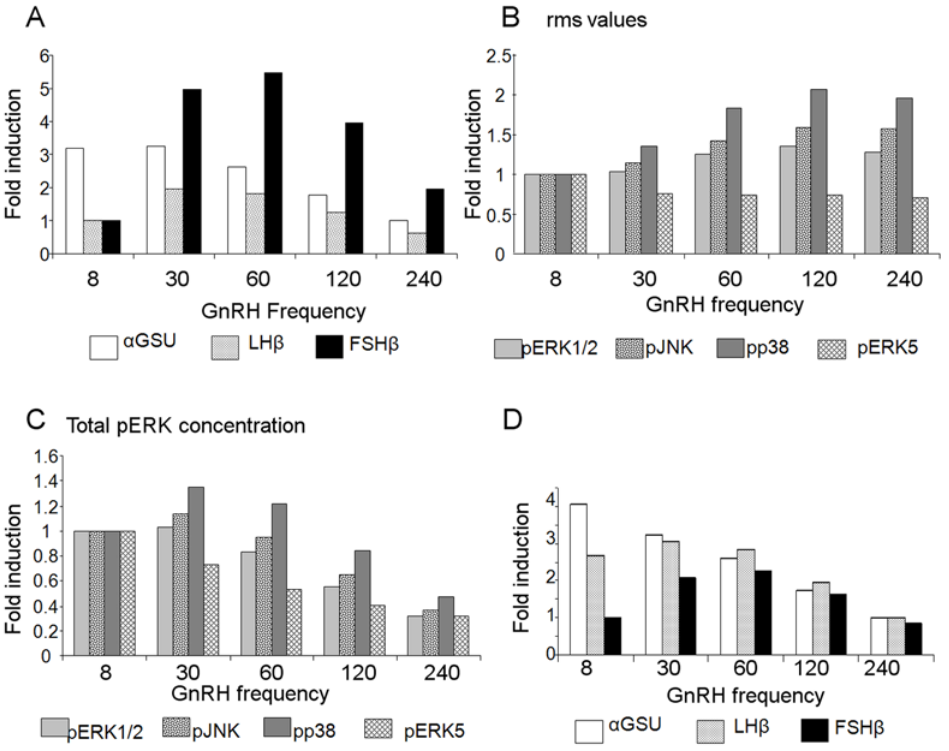
Figure 7. ERK5-negative feedback on GnRH-R expression restores differential gonadotropin subunit gene expression. The receptor- enhanced model was simulated for 1440 min for the same five GnRH frequencies as before. The model was set with e =0 and c =1, so that the system possesses ERK5-negative regulation, but not JNK-positive regulation of GnRH-R expression levels. Thereafter, (A) expression trends of each subunit, (B) rms values and (C) total concentration of each pMAPK were plotted. (D) Thereafter, the model was set with e =1 and c =1, so that the system possesses both ERK5-negative regulation and JNK-positive regulation of GnRH-R expression levels.